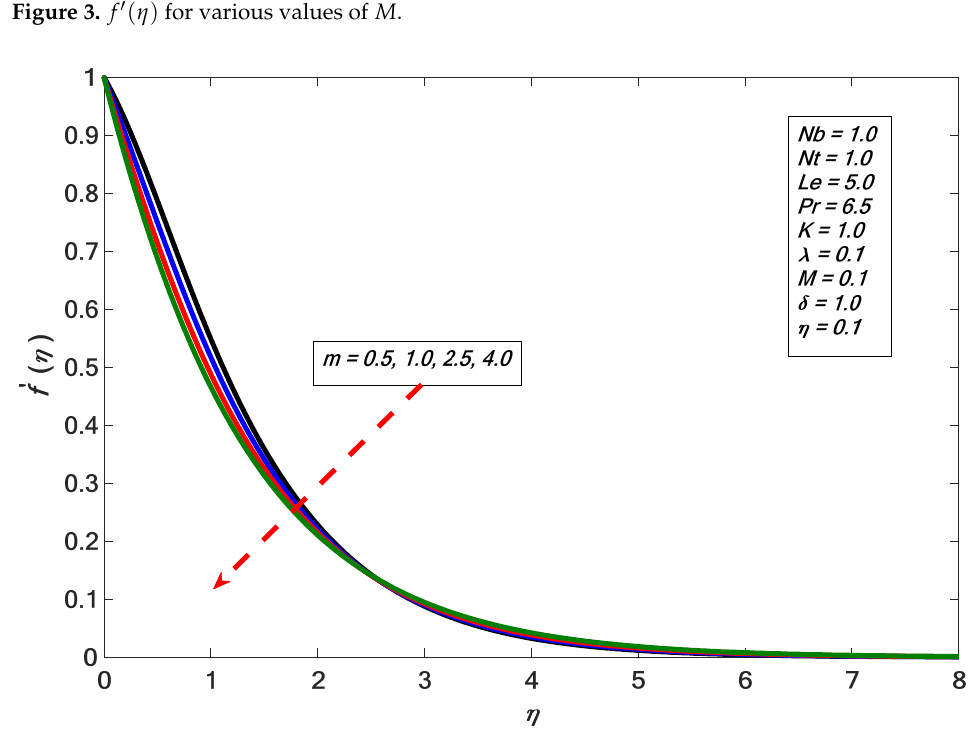
Figure 4. f (cid:48) ( η ) for various values of m Figure 4. 𝑓′(cid:4666)𝜂(cid:4667) for various values of 𝑚.